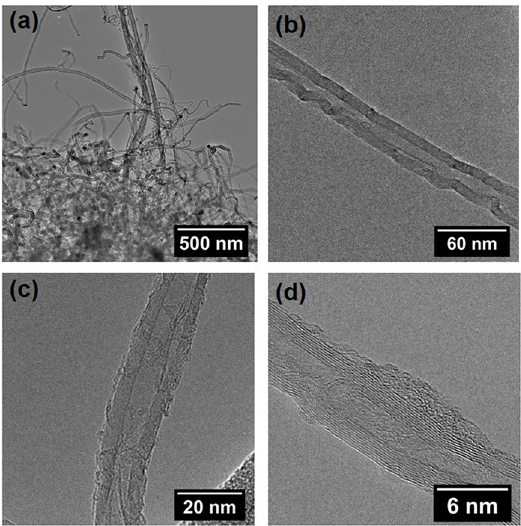
Figure 5. TEM images of the MWCNTs (a) and (b) PAH-MWCNTs, (c) and (d) PSS-MWCNTs.